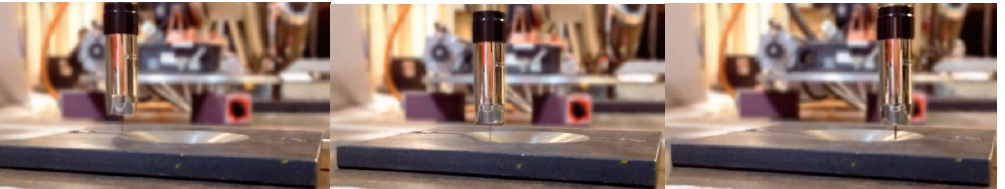
Figure 20. Three robot welding torch positions along a trajectory.